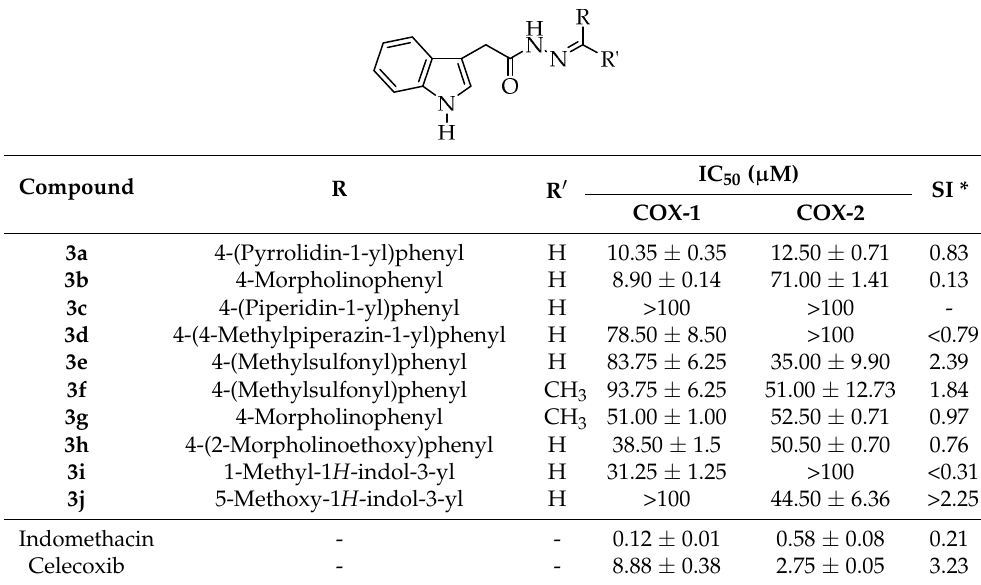
Table 1. COX inhibitory profiles of compounds 3a-j and positive controls.